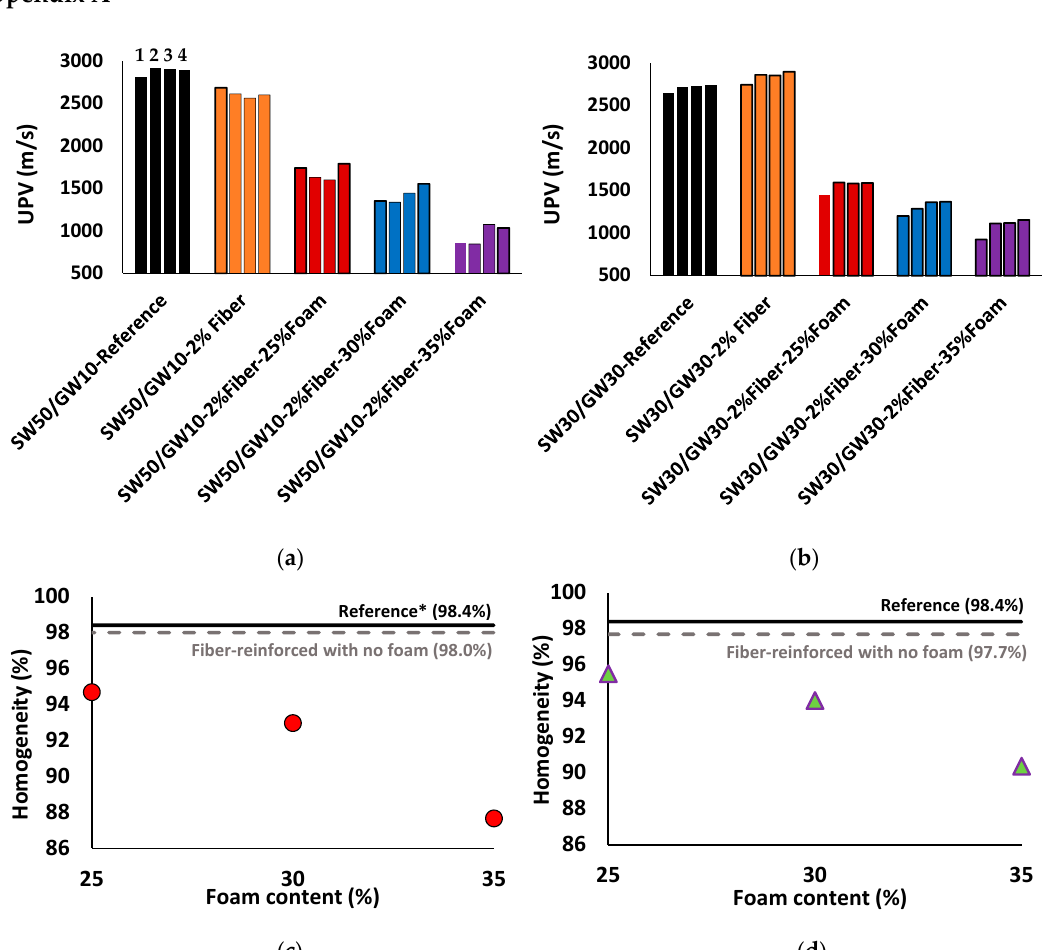
Figure A1. Effects of foam content and fiber addition on the UPV measurements at four different positions of prismatic samples: ( a ) SW50/GW10; ( b ) SW30/GW30; and on the homogeneity of UPV measurements of the mix compositions: ( c ) SW50/GW10; ( d ) SW30/GW30. (* plain mix composition with no foam and fiber addition).